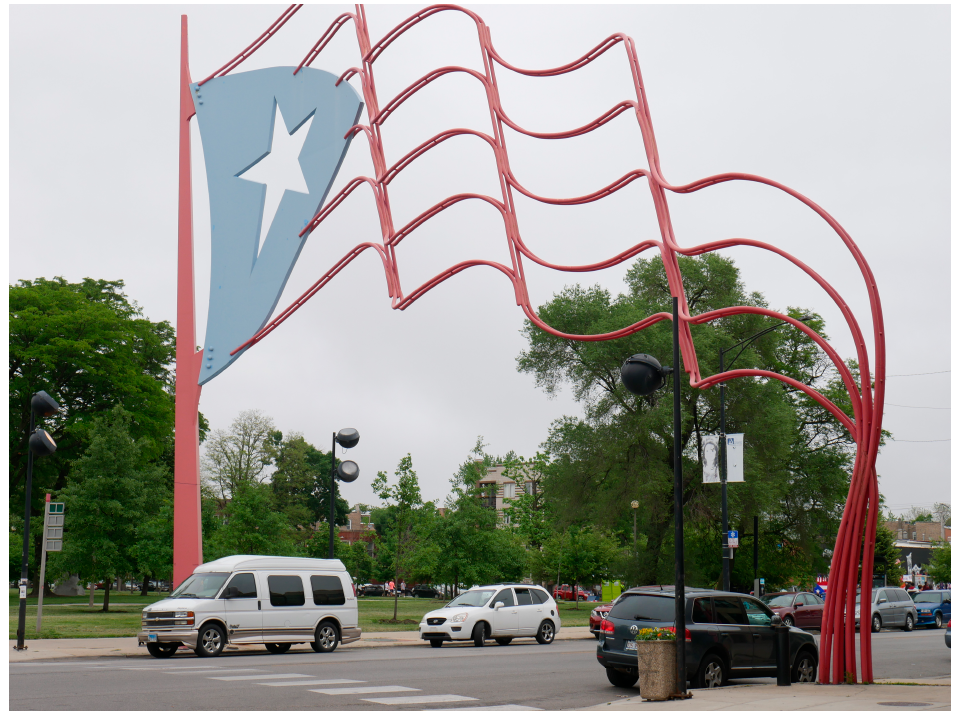
Figure 1. Flag between California Ave. and Division Street at One of the Entrances of Paseo Boricua.